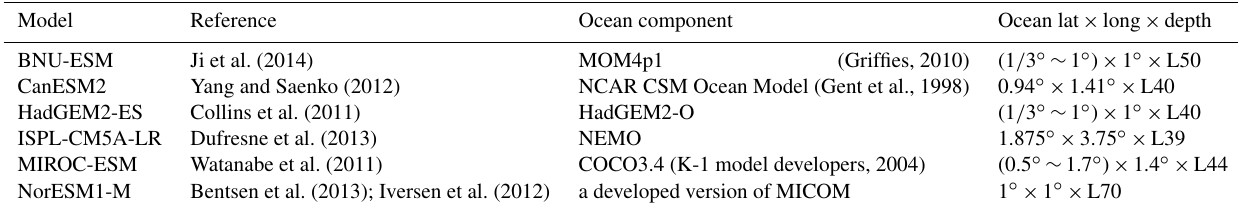
Table 1. Earth system models used in this study.